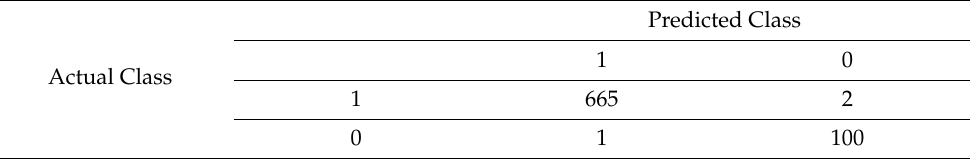
Table 10. Confusion matrix of SMOTE-based deep LSTM.